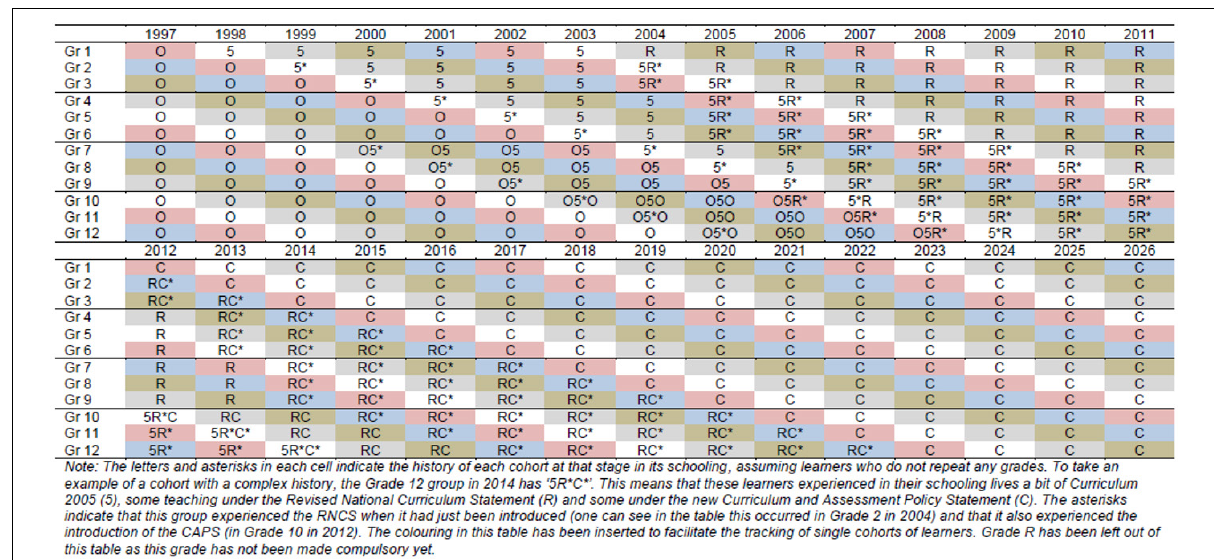
Figure 2: The curriculum experiences of different cohorts of learners from 1997. (O) Old curriculum inherited in 1994; (5) Curriculum 2005; (R) RNCS; (C)